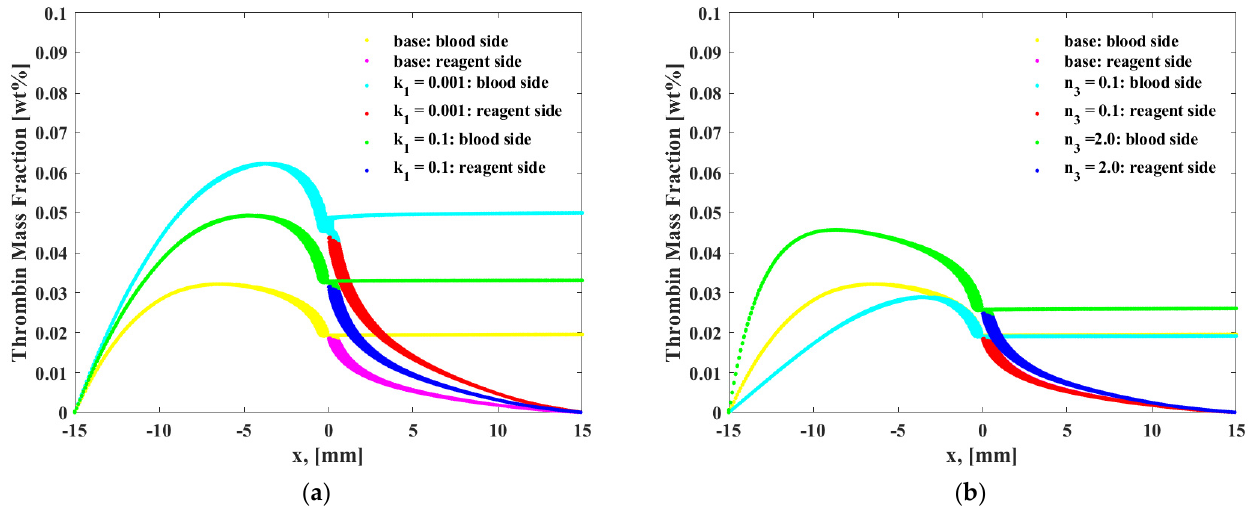
Figure 4. Distribution of the mass fraction of thrombin for ( a ) various k 1 and ( b ) n 3 .